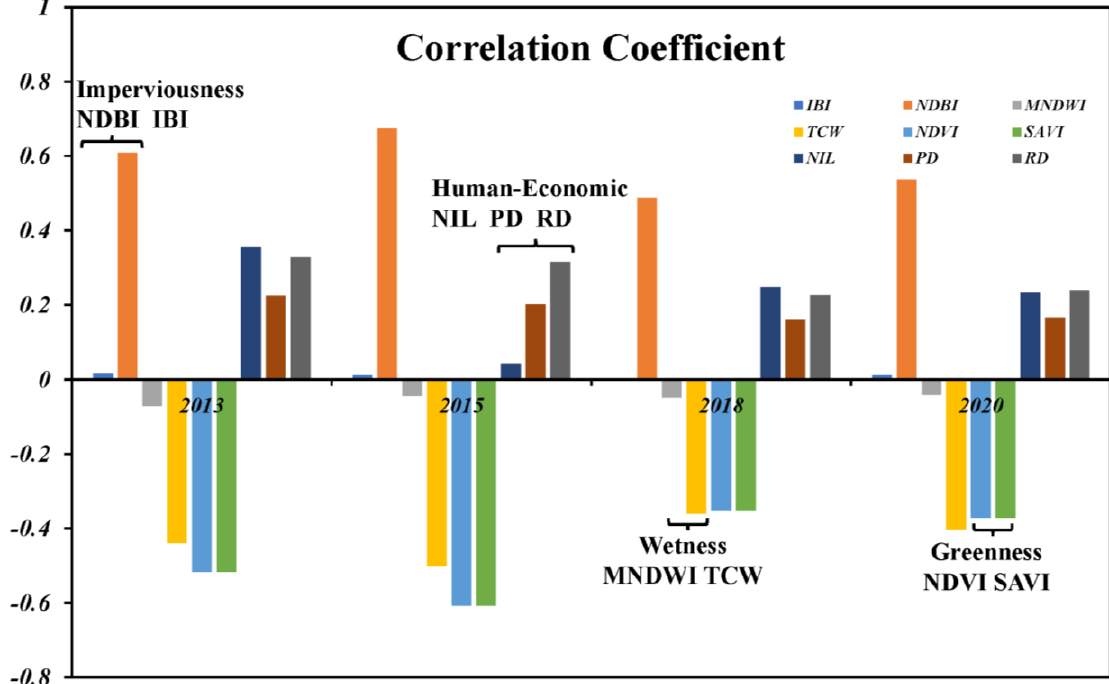
Figure 9. Single factor detection correlation, (+) represents positive correlation, ( − ) represents nega- tive